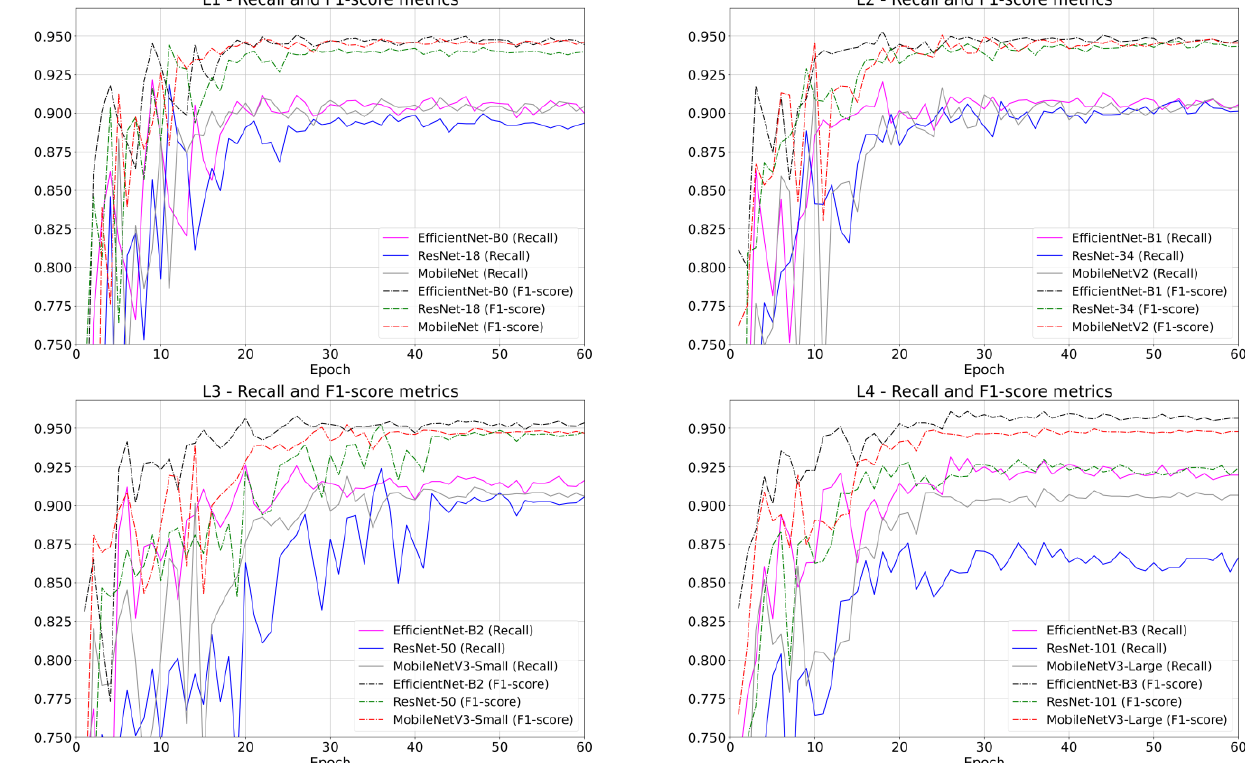
Figure 5. Recall and F1-score of all four tiers ( L1 – L4 ) of the evaluated networks.